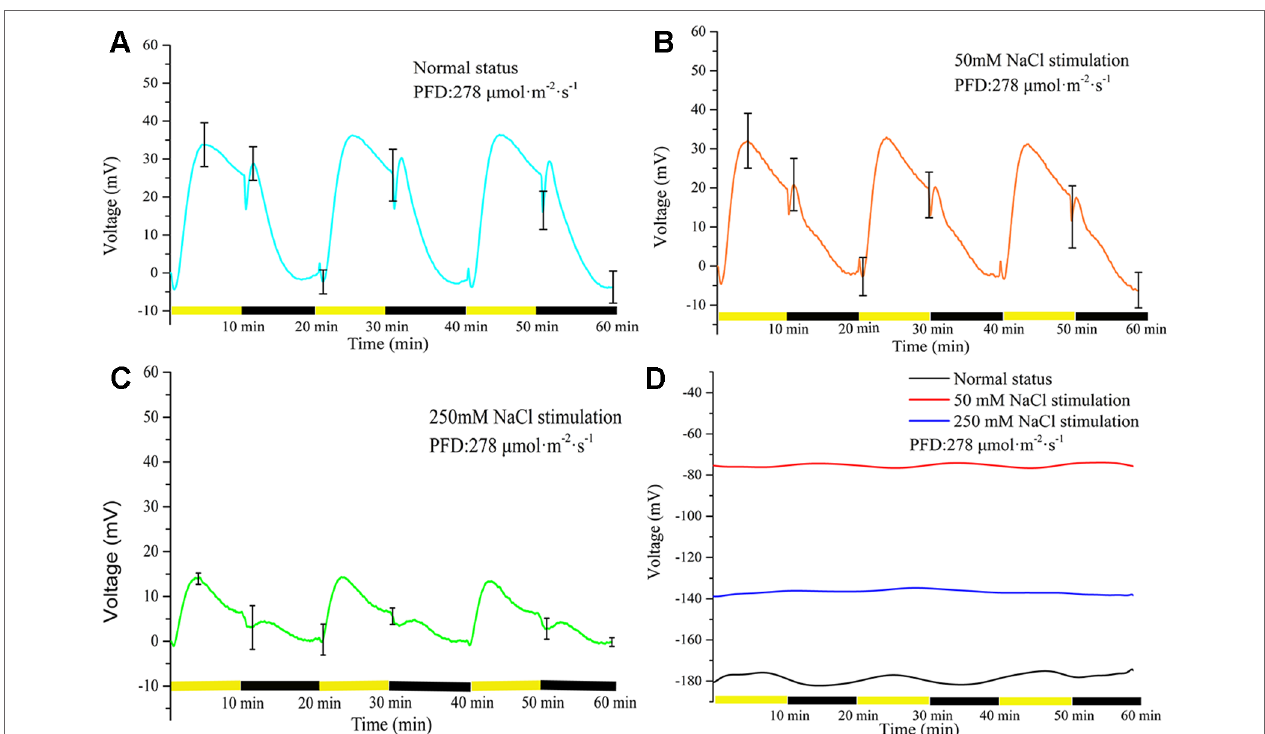
FIgURe 4 | Effects of three concentrations of NaCl on light-induced rhythmical bioelectrogenesis. With increase in NaCl concentration, the amplitude of the surface potential at the same position of the same leaf gradually decreased and the waveform also varied considerably. The results indicated that the leaf response to light gradually decreased with increase in salt stimulation intensity. The potential change without leaf under illumination/darkness was shown in Supplementary Figure 3 . The leaves used in (a – C) were living, whereas a heat-killed leaf was used in (D) . To make statistical analysis on the amplitude of the voltage, the baseline values in (a – C) were subtracted. Mean ± SE ( n = 6); n—number of